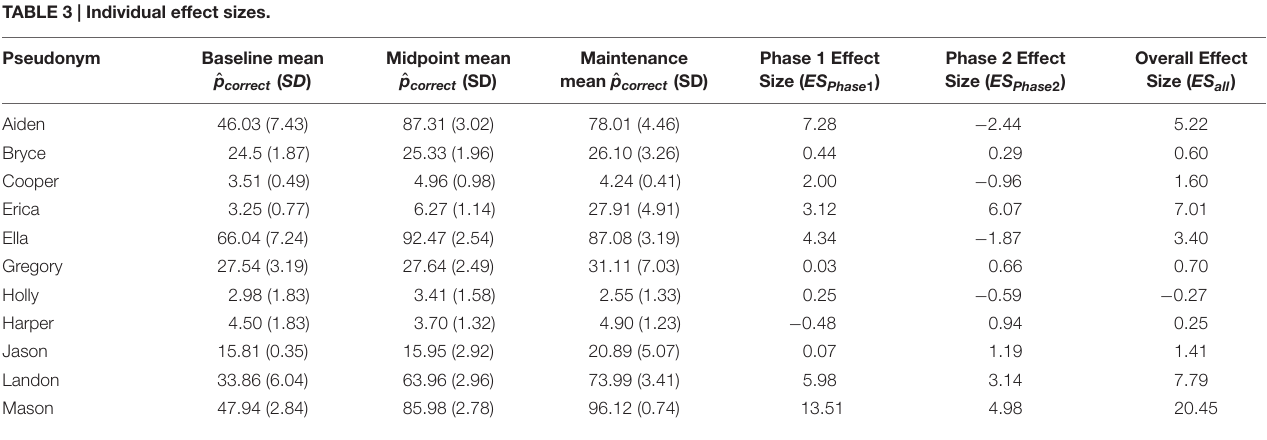
TABLE 3 | Individual effect